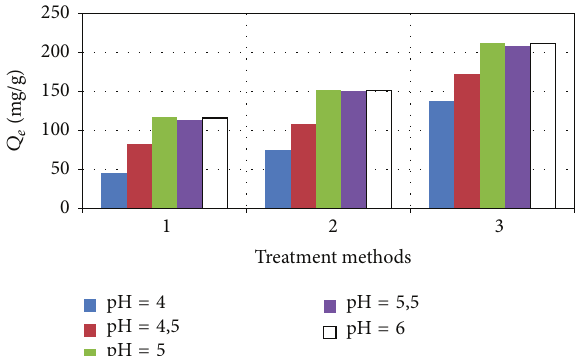
Figure 4: Pb(II) adsorption performance of the AC produced after physicochemical and thermal treatment.